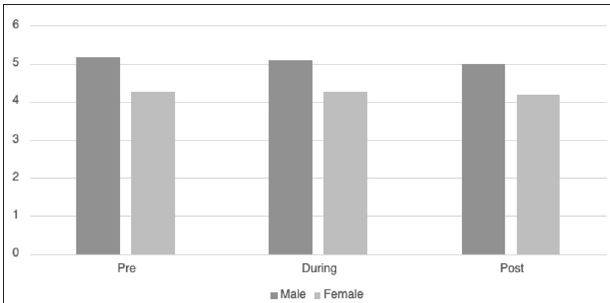
FIGURE 1 | Differences in HRVi Median by sex. Males had higher HRVi Median at every time point compared to females ( F (2, 93) = 5.45, p = 0.022, η 2 p = 0.055).